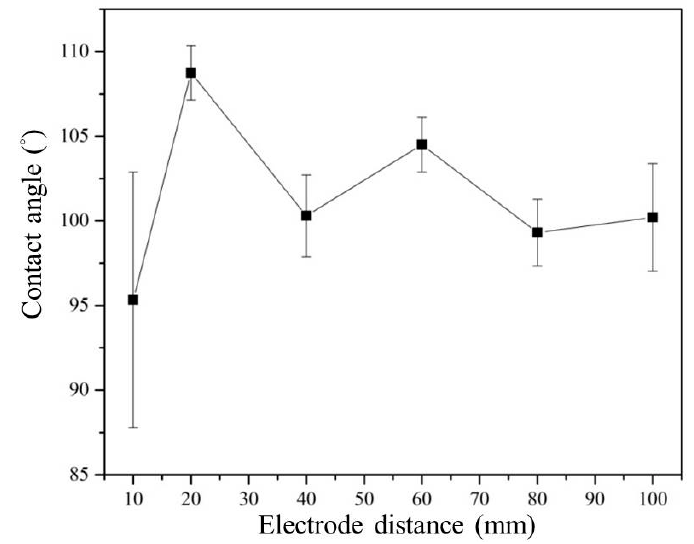
Figure 12. Contact angle mean and standard deviation values for various electrode distances when the cathodic specimen speed of 0.125 mm/s and the applied voltage of 220 V are fixed.